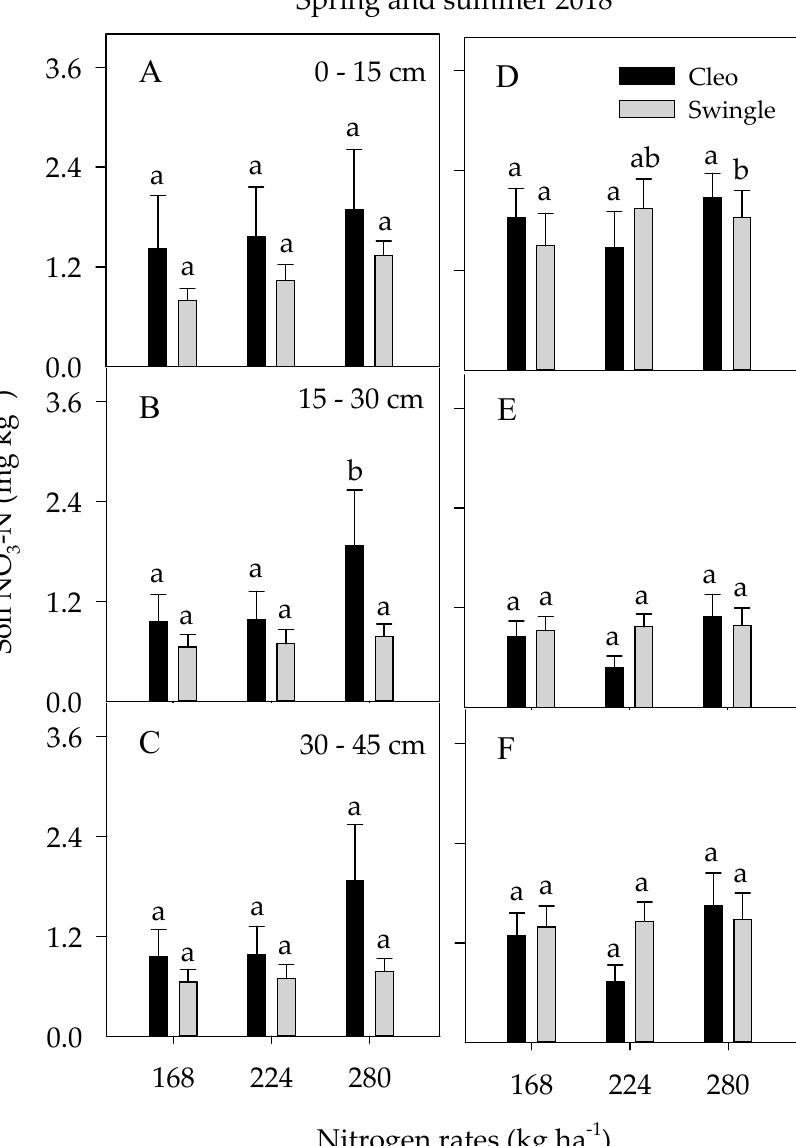
Figure 5. Soil NO 3 -N dynamics and accumulation of Huanglongbing (HLB)-affected Hamlin citrus trees budded on Cleo and Swc rootstocks during spring ( A – C ) and summer ( D – F ) 2018 in three soil depths (0–15, 15–30, and 30–45 cm). Means with different lower case letters are significantly different at p ≤ 0.05, based on the Tukey–Kramer honestly significant difference test (n = 36). Soil ammonium nitrogen . The concentration of NH 4 -N in the topmost soil depth was higher as